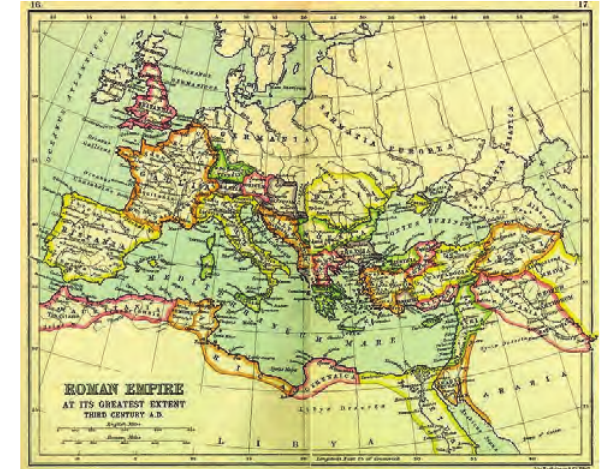
Fig. 3. Map of the Roman Empire at it‘s greatest